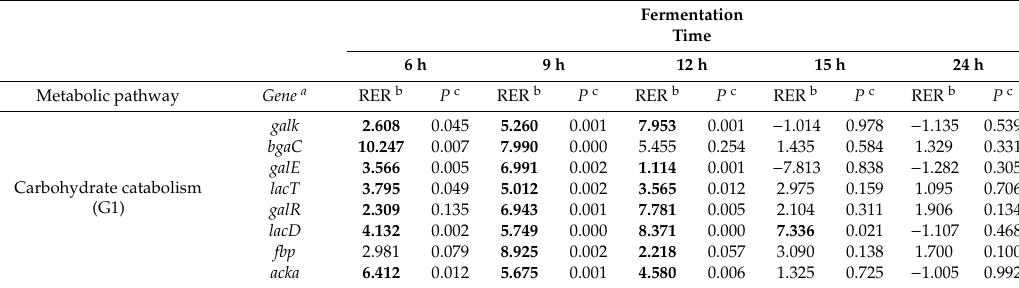
Table 3. Relative expression ratio (RER) of genes involved in the carbohydrate catabolism, EPS operon, amino acid biosynthesis and lipid metabolism, stress and cellular responses, and other functions (microbial metabolism in diverse environments) of L. rhamnosus RW-9595M over 24 h during growth in whey permeate in co-culture with S. cerevisiae